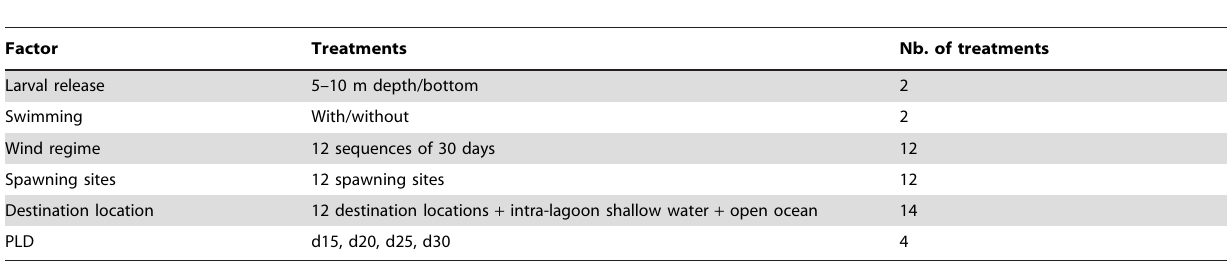
Table 3. Summary of the factors tested in the connectivity analysis.